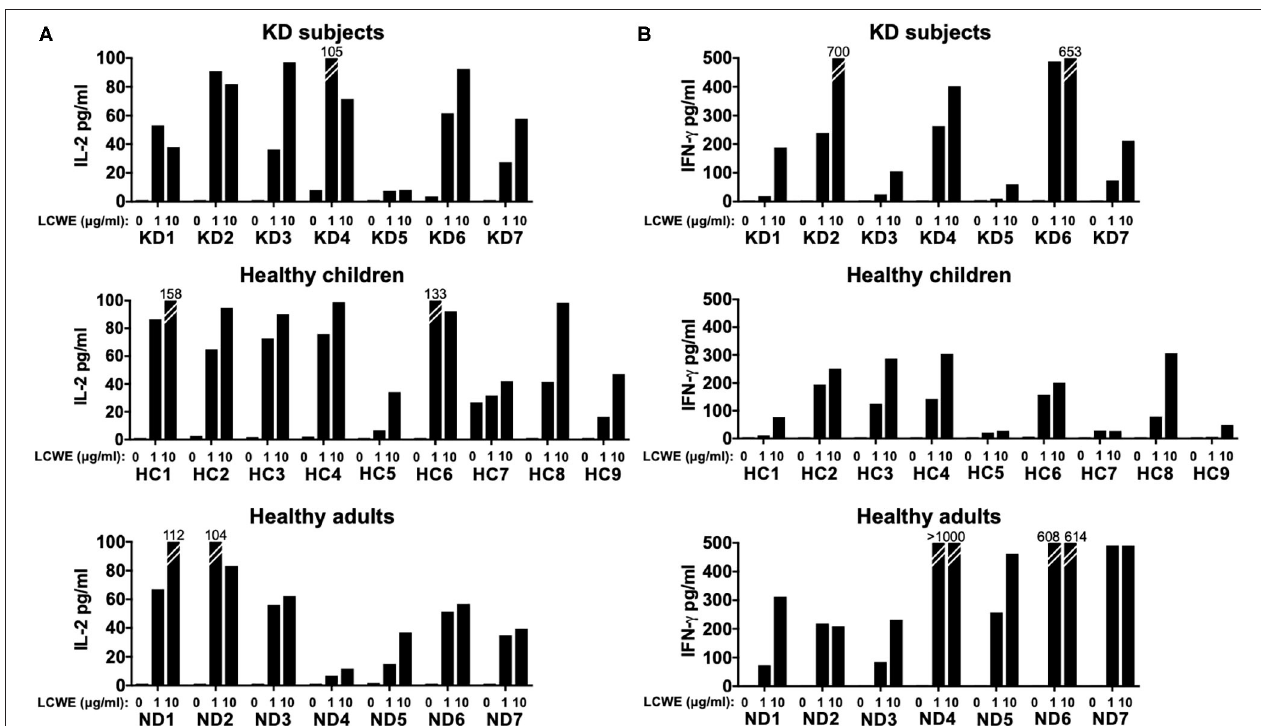
FIGURE 2 | IL-2 and IFN γ production by T cells in response to LCWE. To validate the antigen-specific response to LCWE, we measured IL-2 (A) and IFN γ (B) secretion in culture supernatants. CD4 + and CD8 + T cells secreted IFN γ , suggesting a pro-inflammatory T helper 1 and cytotoxic functional phenotype in response to